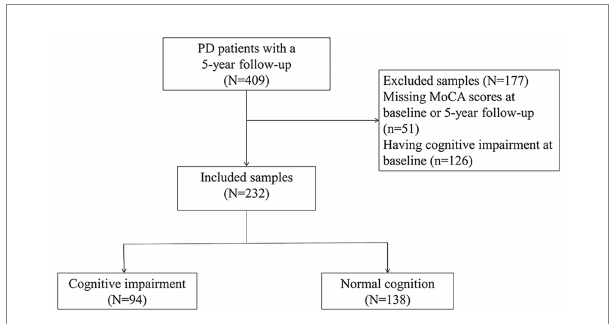
FIGURE 1 Flowchart of patient selection and